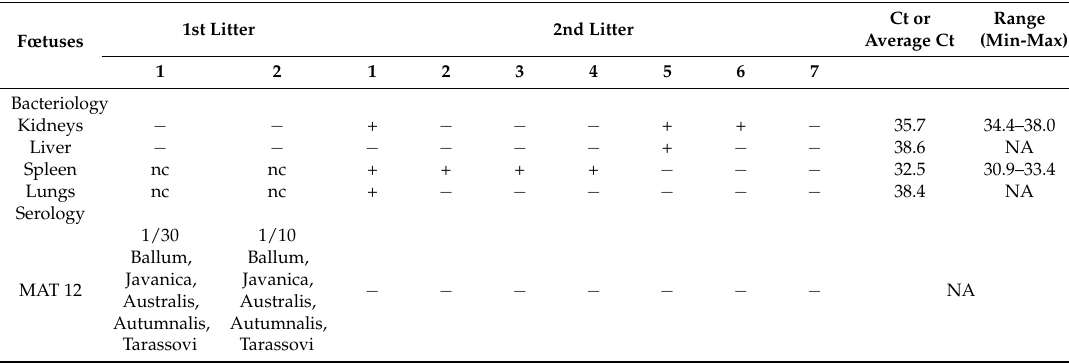
Table 2. Bacteriological and serological results of two swine litters collected between late fall and winter